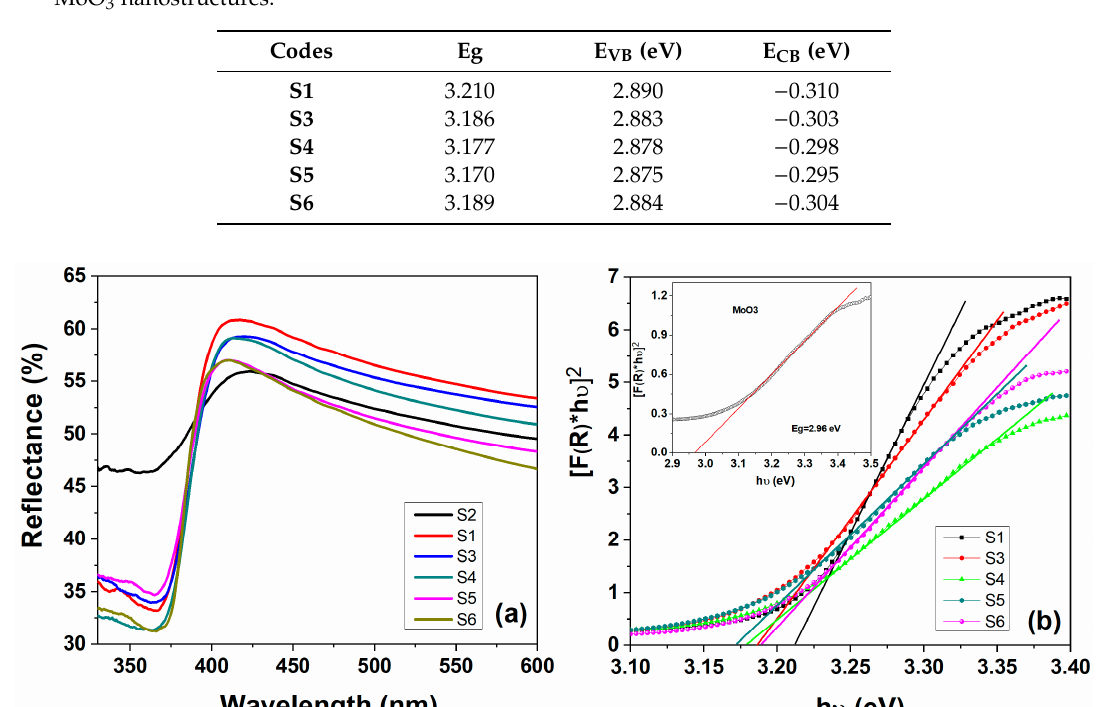
Table 2. Calculated band gap energies and band edge potentials for pure ZnO and ZnO-incorporated MoO 3 nanostructures.